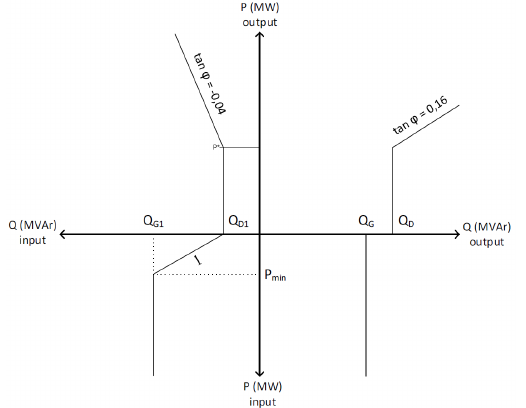
Figure 1. TSO guidelines regarding power exchange with a DN. Input stands for exporting power from the distribution to the transmission and output stands for export